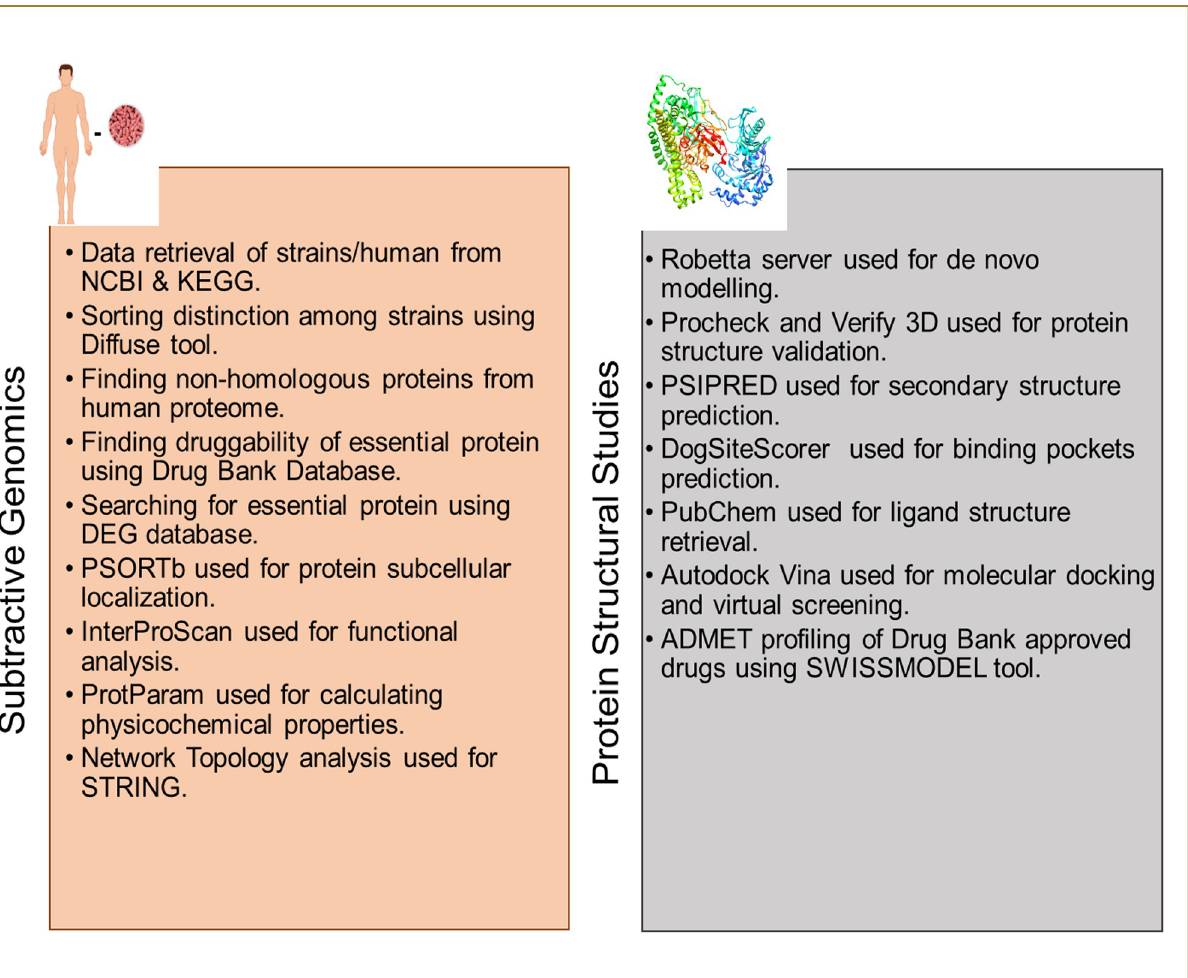
Fig 1. Flow chart of applied methodology in current study. Potential drug targets against S . marcescens identified using this methodology.